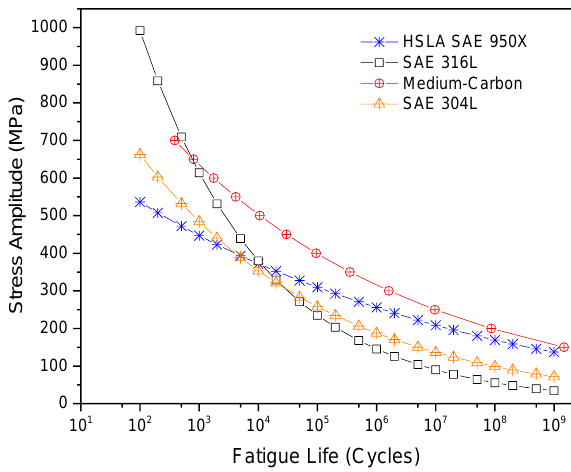
Figure 7. S–N curves of HSLA SAE 950X [29], Medium-Carbon Steel [30], SAE 316L [31], and SAE 304L [32] Figure 7: S–N curves of HSLA SAE 950X [30], medium-carbon steel [31], SAE 316L [32], and SAE 304L [33]